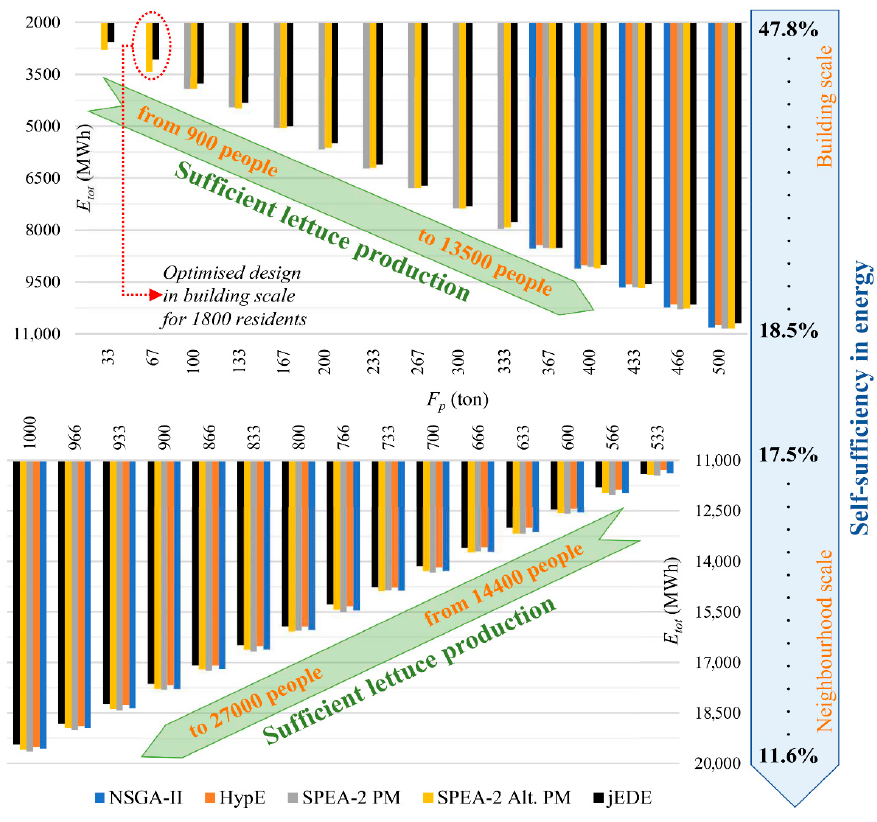
Figure 24. Self-sufficiency potential of Europoint complex for neighbourhood scale.